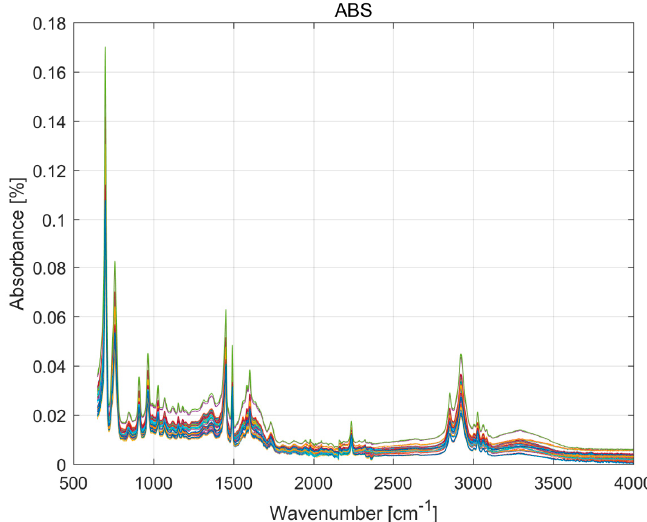
Figure 3. The 50 FTIR datasets per a 3D-printed ABS specimen.